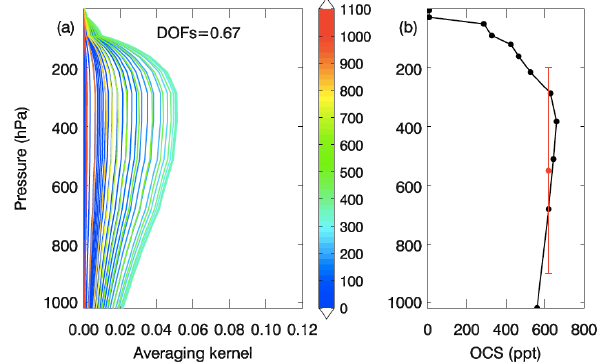
Fig. 5. (a) Averaging kernels for different vertical levels in colored lines. (b) Retrieved OCS profile (black line with dots) and its corresponding tropospheric OCS in red. Fig. 6. Estimated errors for a single sounding retrieval near Mauna Loa. The nonoptimal assumed variability used to constrain the OCS retrieval is the black line with dots. The a posteriori total error is composed of smoothing error (red), measurement error (light blue), and systematic errors due to H 2 O (dark blue), CO 2 (green) and atmospheric temperature (yellow). Note that since the systematic error owing to other trace gases or temperature is quite small compared to other errors, we multiply the errors by ten. (a) Errors in percentage. (b) Errors in units of ppt.